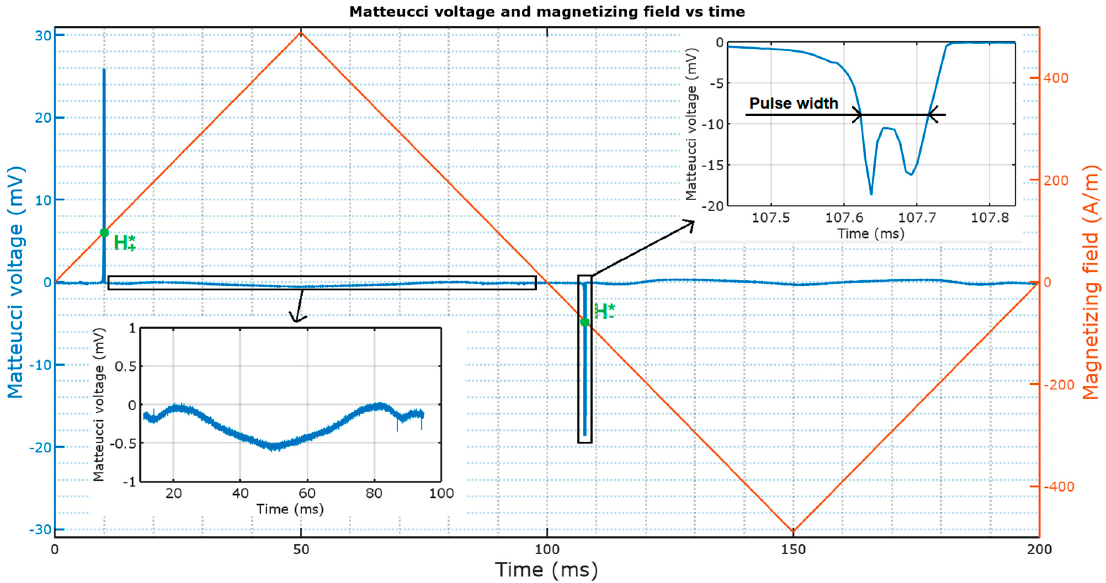
Figure 4. Measured values on exemplary Matteucci effect (ME) pulse plot ( H ∗ + —positive peak triggering field, H ∗ − —negative peak triggering field).